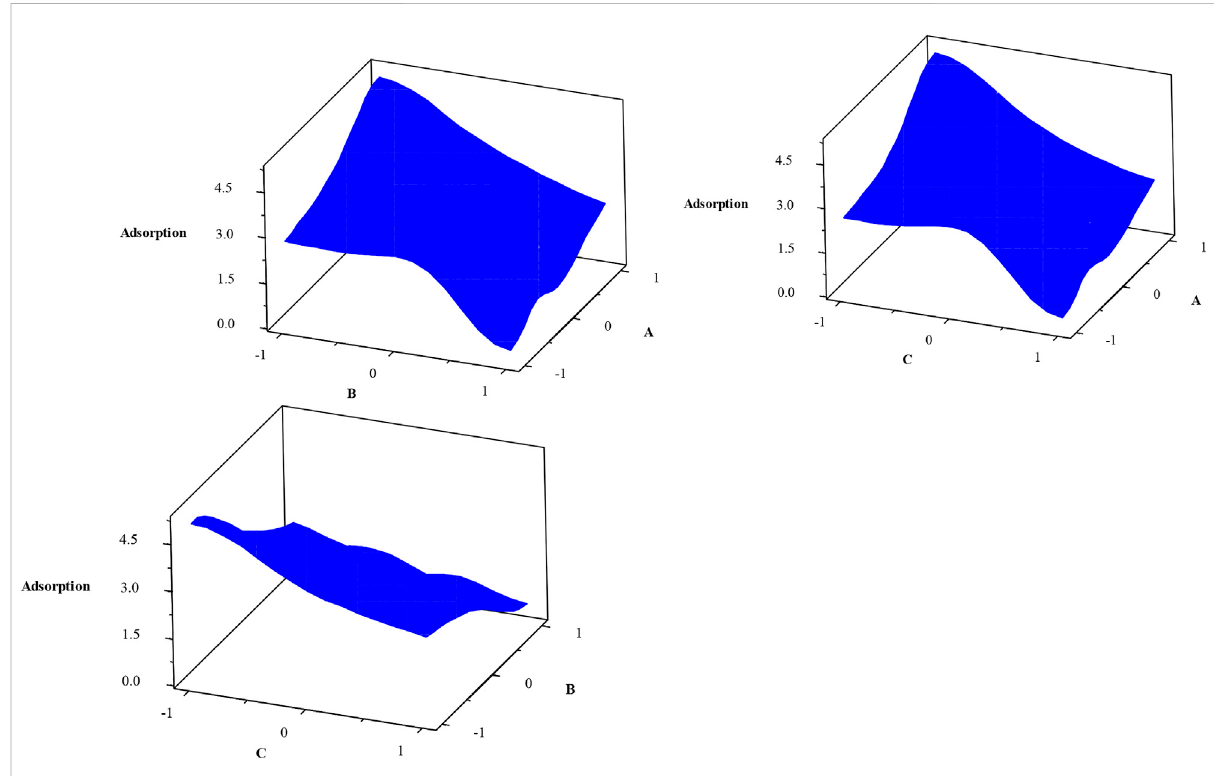
FIGURE 11 3D surface plot for the relation between experimental parameters and H 2 S gas